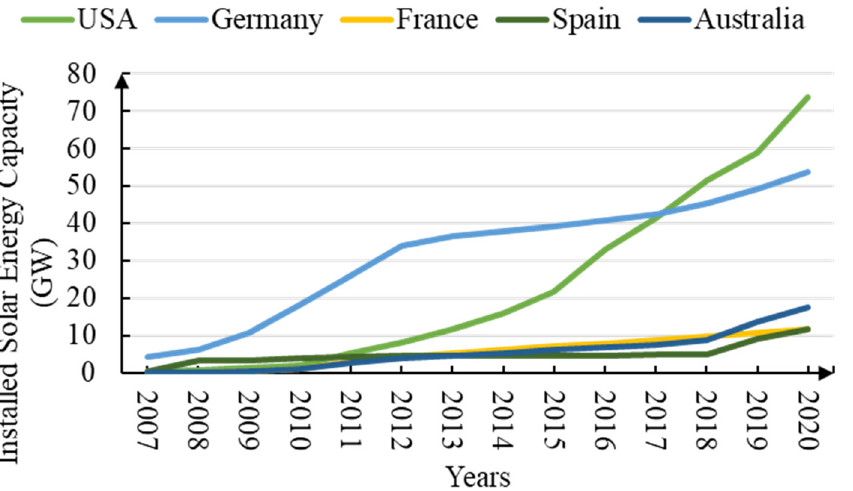
Figure 11. Installed solar energy capacity as per the Statistical Review of World Energy reported in 2021.